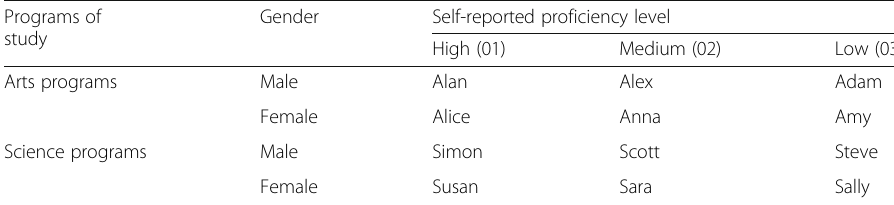
Table 1 Interviewee profile Programs of